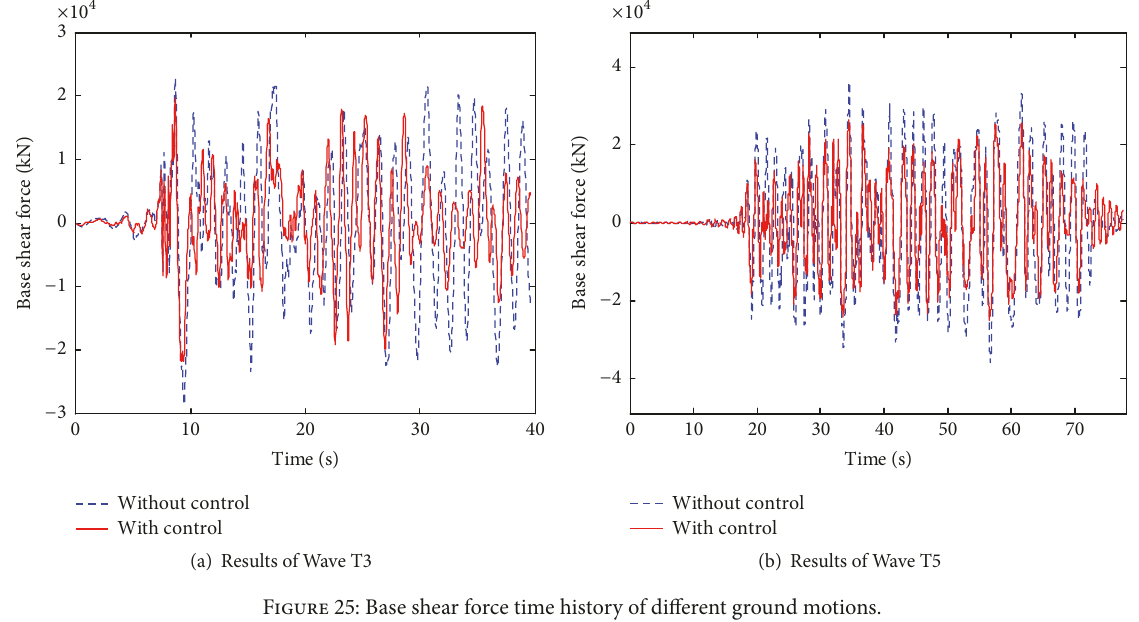
Figure 25: Base shear force time history of different ground motions.